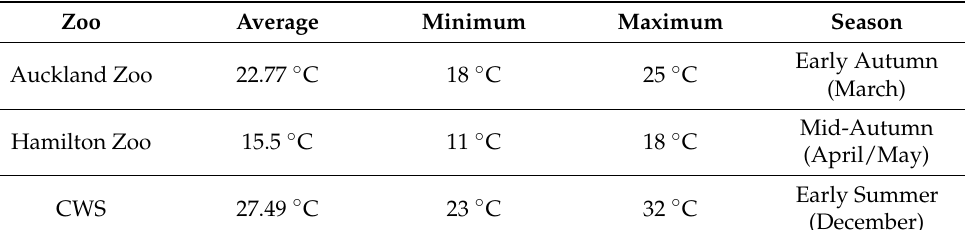
Table 4. Temperatures across facilities during the study period, from observational dataset. Showing only daytime temperatures (0930–1930 at Auckland Zoo, 1000–1600 at Hamilton Zoo, and 0715–1630 at CWS).